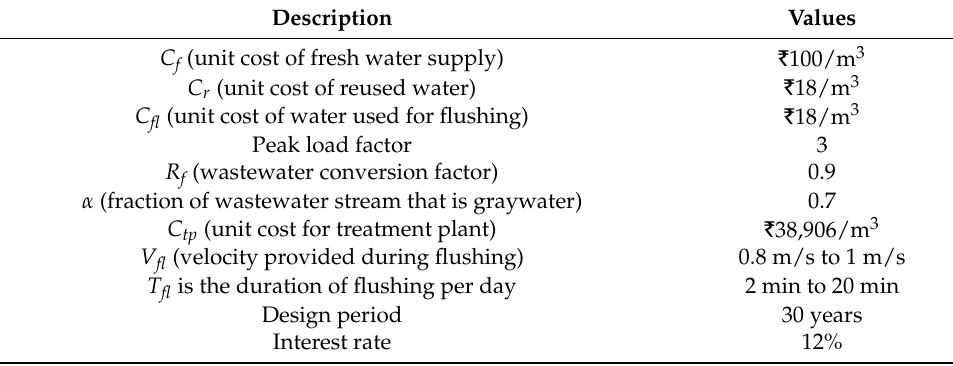
Table 1. Input data for the network in Figure 1 for graywater reuse.